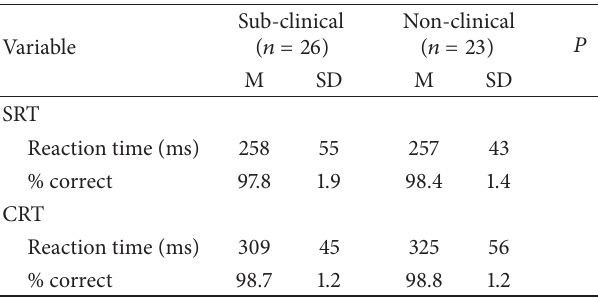
Table4:Meansandstandarddeviationsinthesub-clinicalandnon- clinical groups for the SRT and CRT task